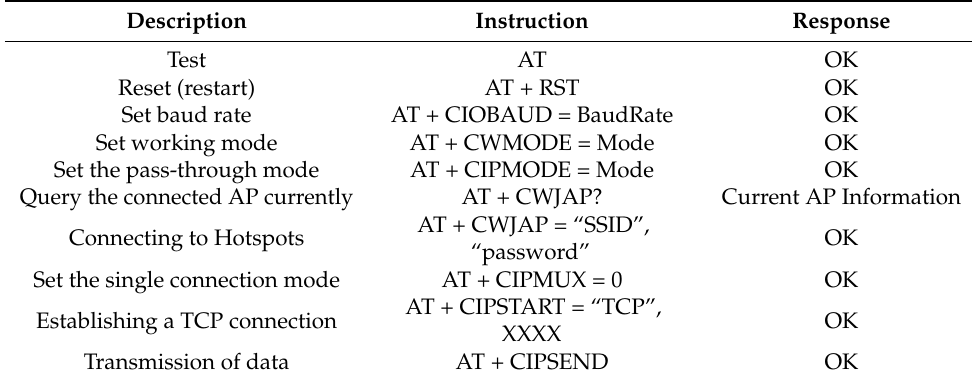
Figure 8. Block program diagram of intelligent sensing unit. Table 2. AT instruction set of